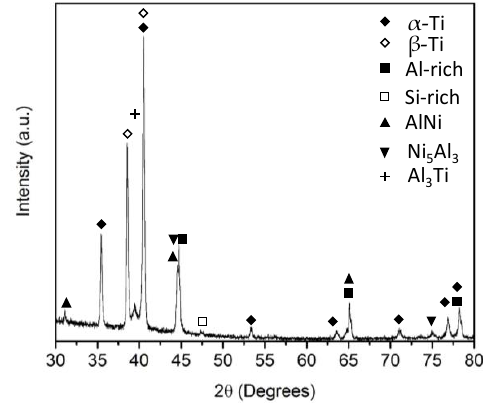
Figure 7. XRD pattern of the brazed joint.